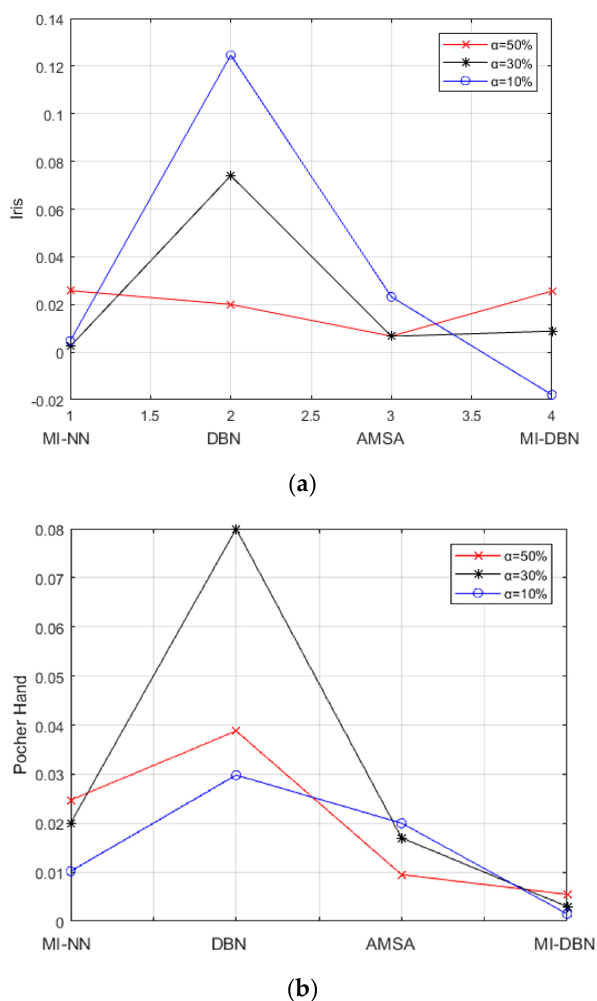
Figure 4. Improvements over the previous methods. ( a ) Iris; ( b ) Poker Hand.